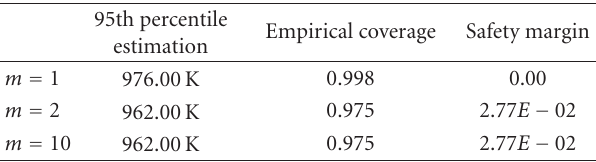
Table 3: Results for the point estimation of the 95th percentile and the corresponding safety margin obtained through the order statis- tics method. 95th percentile